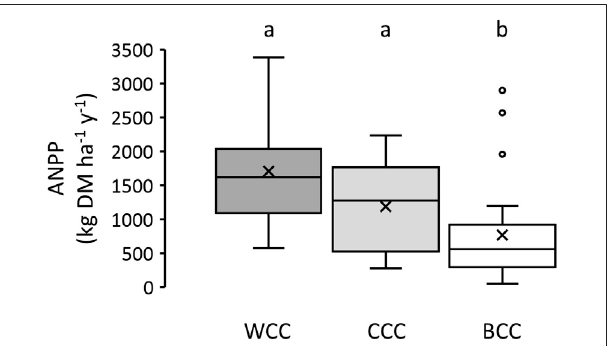
FIGURE 5 | Box and whiskers plot of ANPP for each of the cover crop layout.Horizontalblackline,x-shaped cross,boxborders andwhiskersstand for the median, the mean, quartiles and outliers. Different letters over the box- plot indicate signi fi cant differences ( p < 0.05). WCC, CCC and BCC stand for olives groves where TSCC occupied the whole area, was absent under tree canopy or only occupied a strip of the inter-row area,